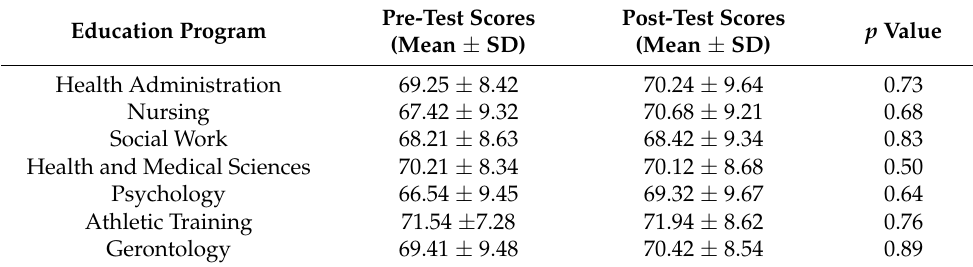
Table 2. Comparison of